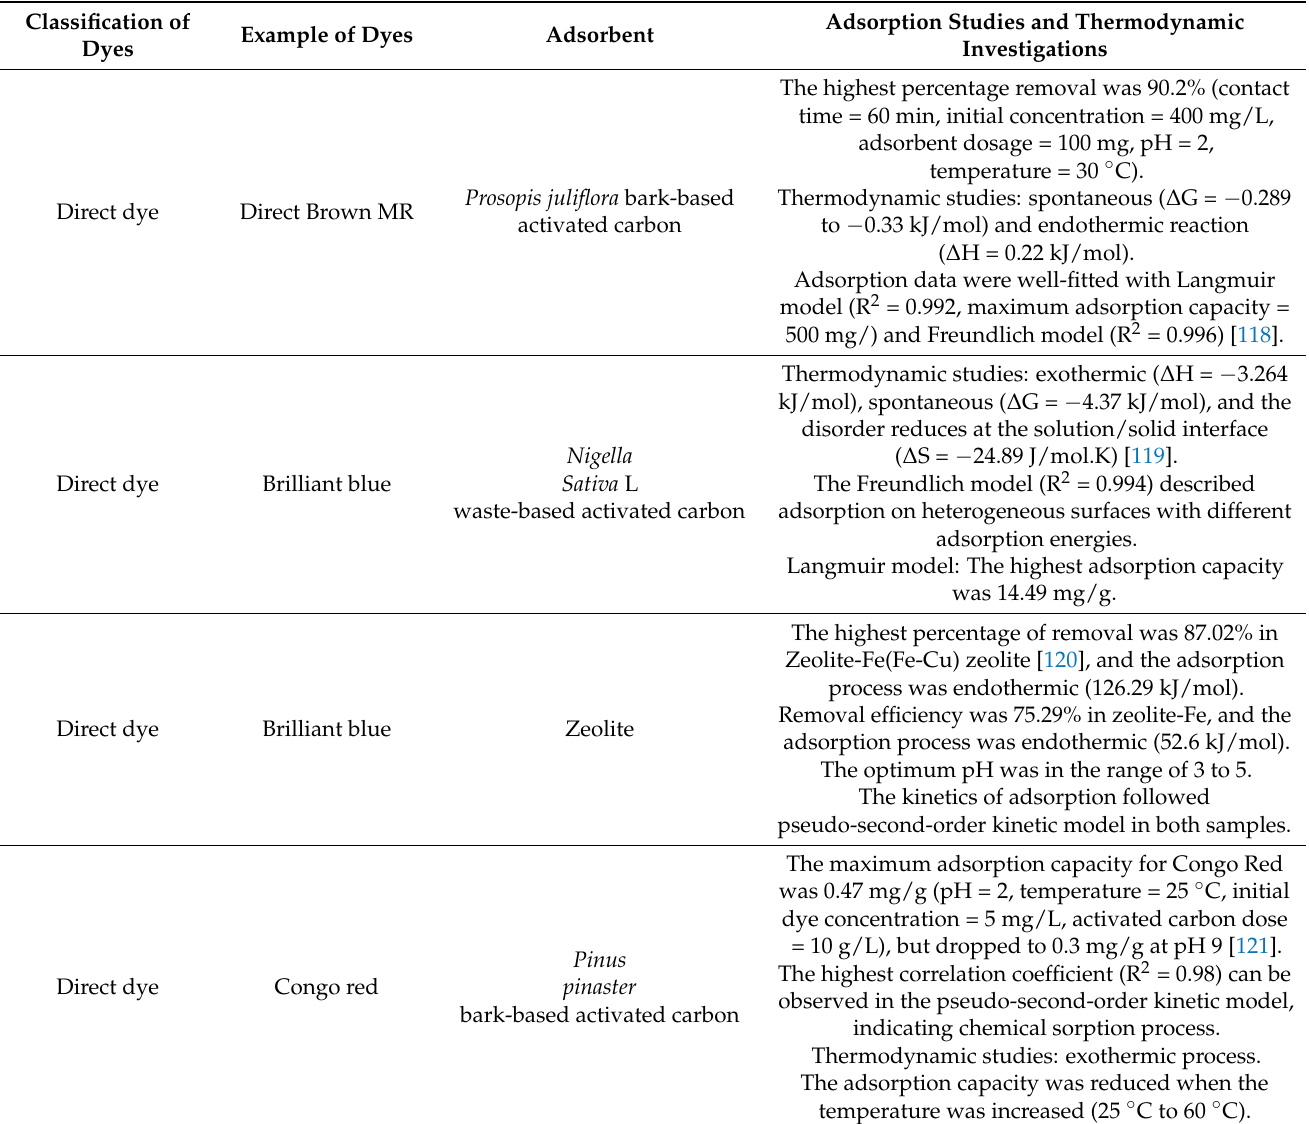
Table 9. Kinetic and adsorption study of dye removal using various types of